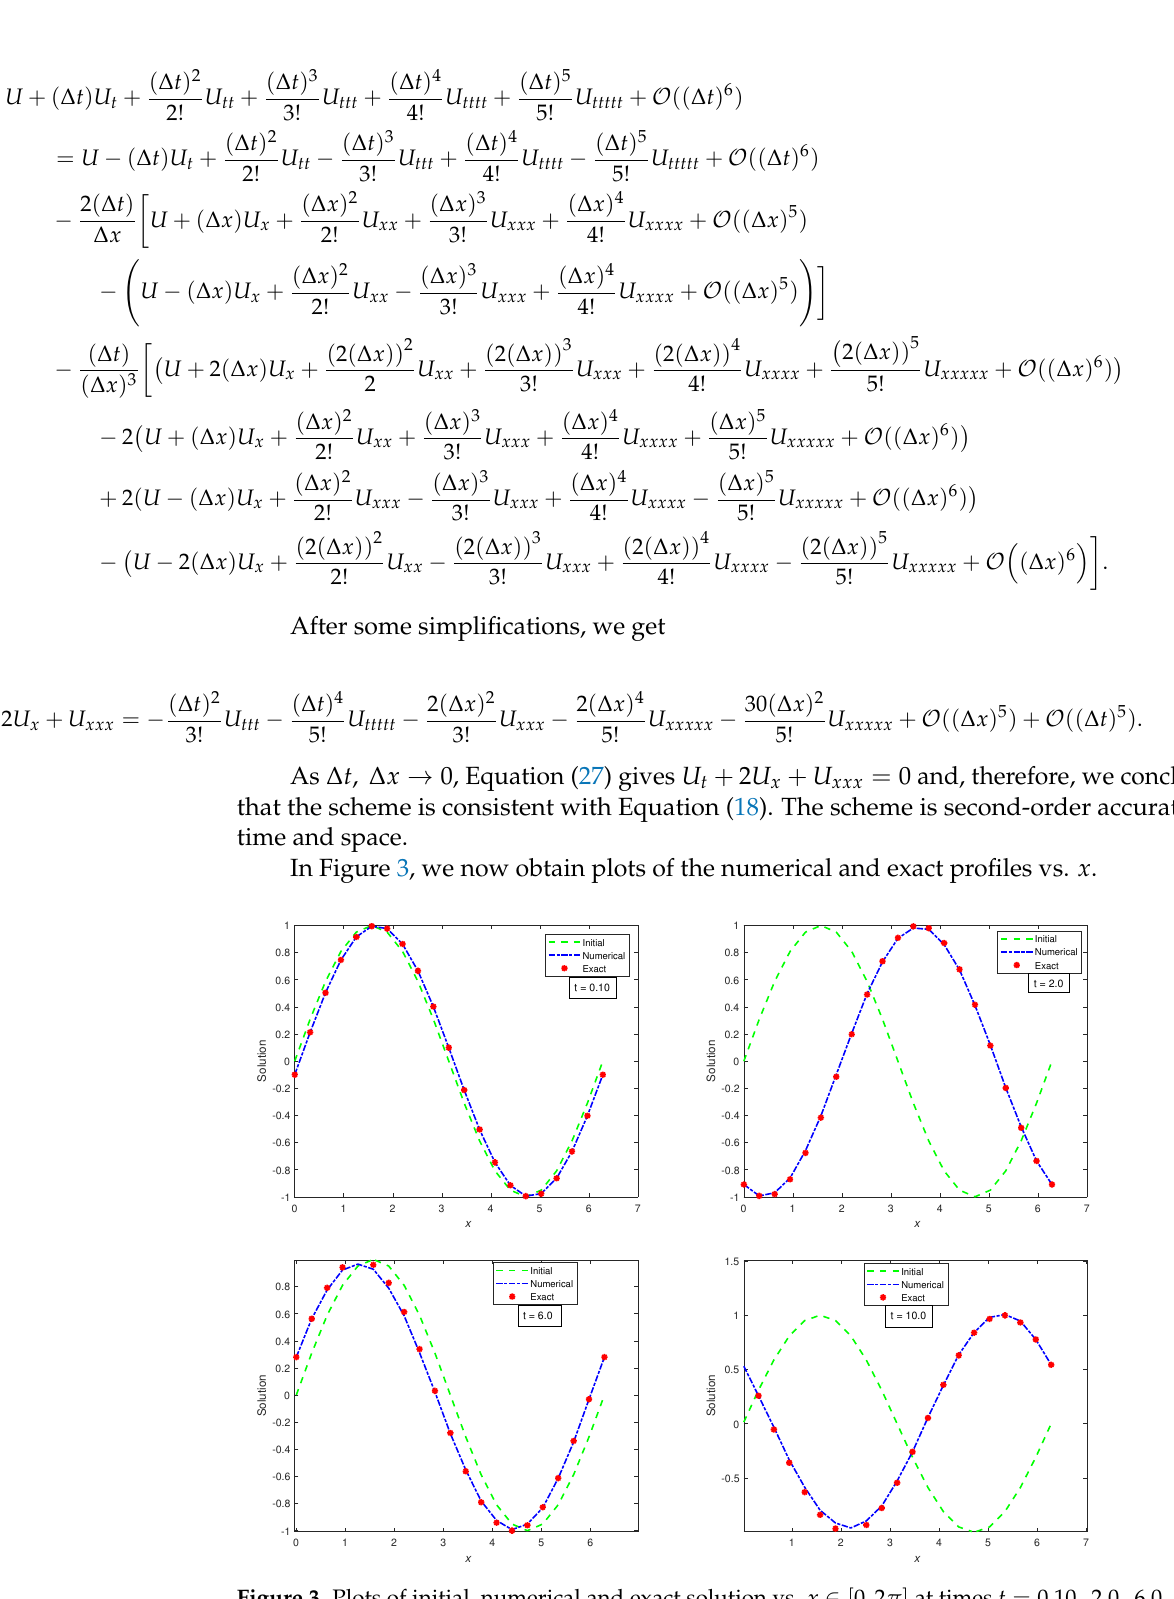
Figure 3. Plots of initial, numerical and exact solution vs. x ∈ [ 0,2 π ] at times t = 0.10, 2.0, 6.0, 10.0, π using FDM with ∆ t = 10 − 3 and ∆ x =